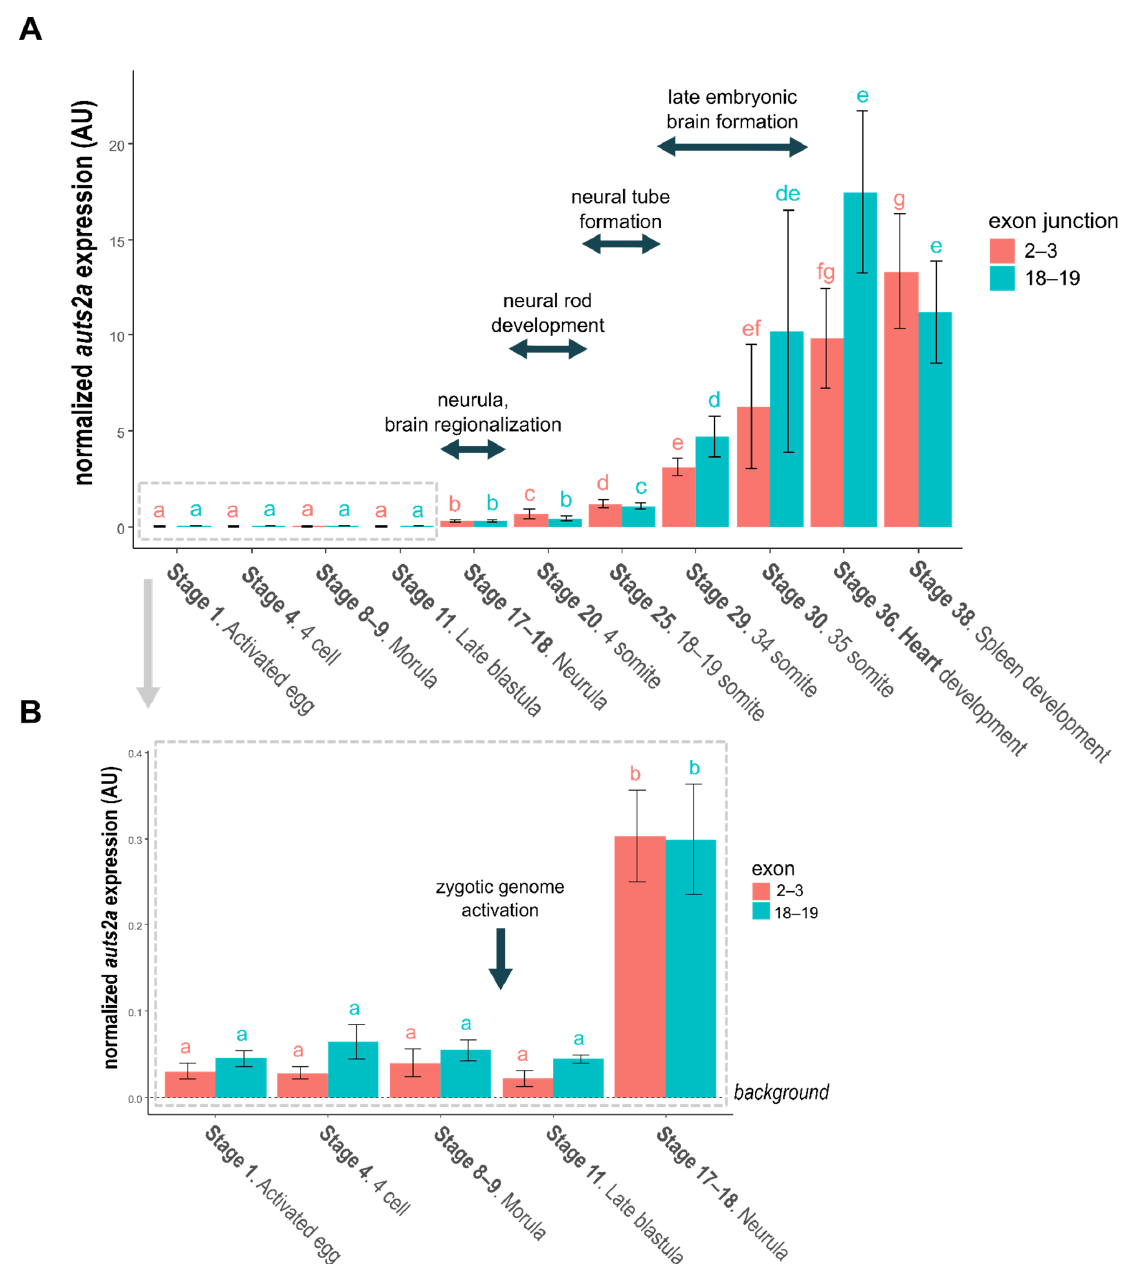
Figure 5. ( A ) . Japanese medaka auts2a expression during embryonic development. ( B ) . Focus on early embryonic development. For both panels bars represent the mean normalized expression calculated using 4 different pools of embryos. The standard deviation is displayed. Primers surrounding exons 2–3 junction target the full-length isoform. Primers surrounding the exons 18–19 junction target both full-length and short C-terminal isoforms. Comparisons were performed independently for each set of primer. Stages sharing the same letter are not significantly different ( p < 0.05).